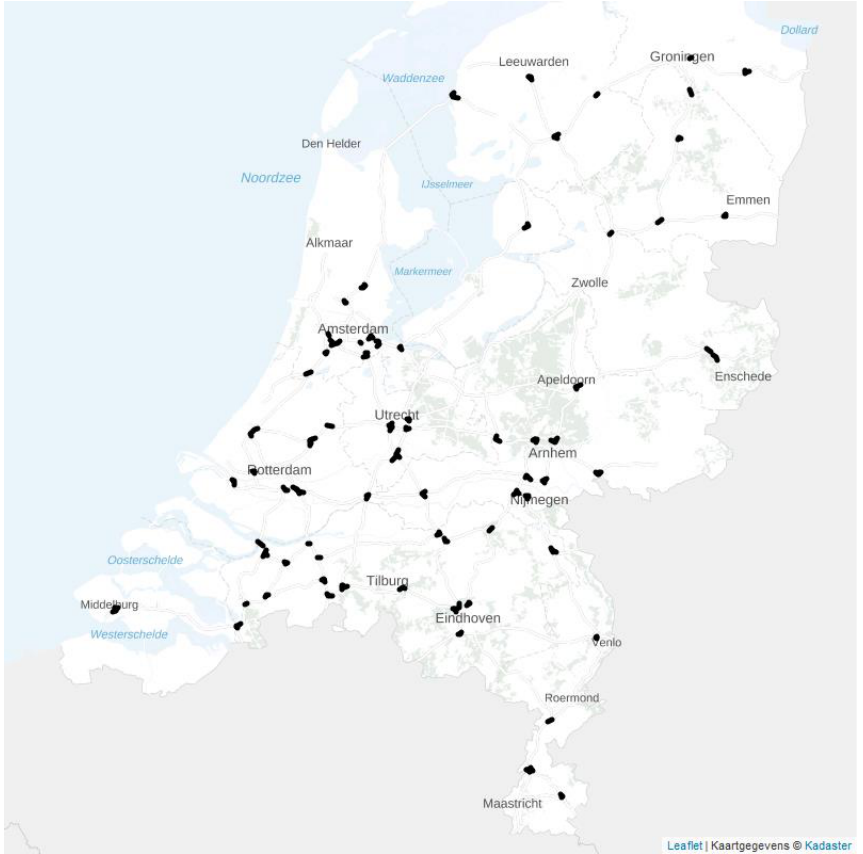
Figure 2. Map of The Netherlands showing the selected freeway